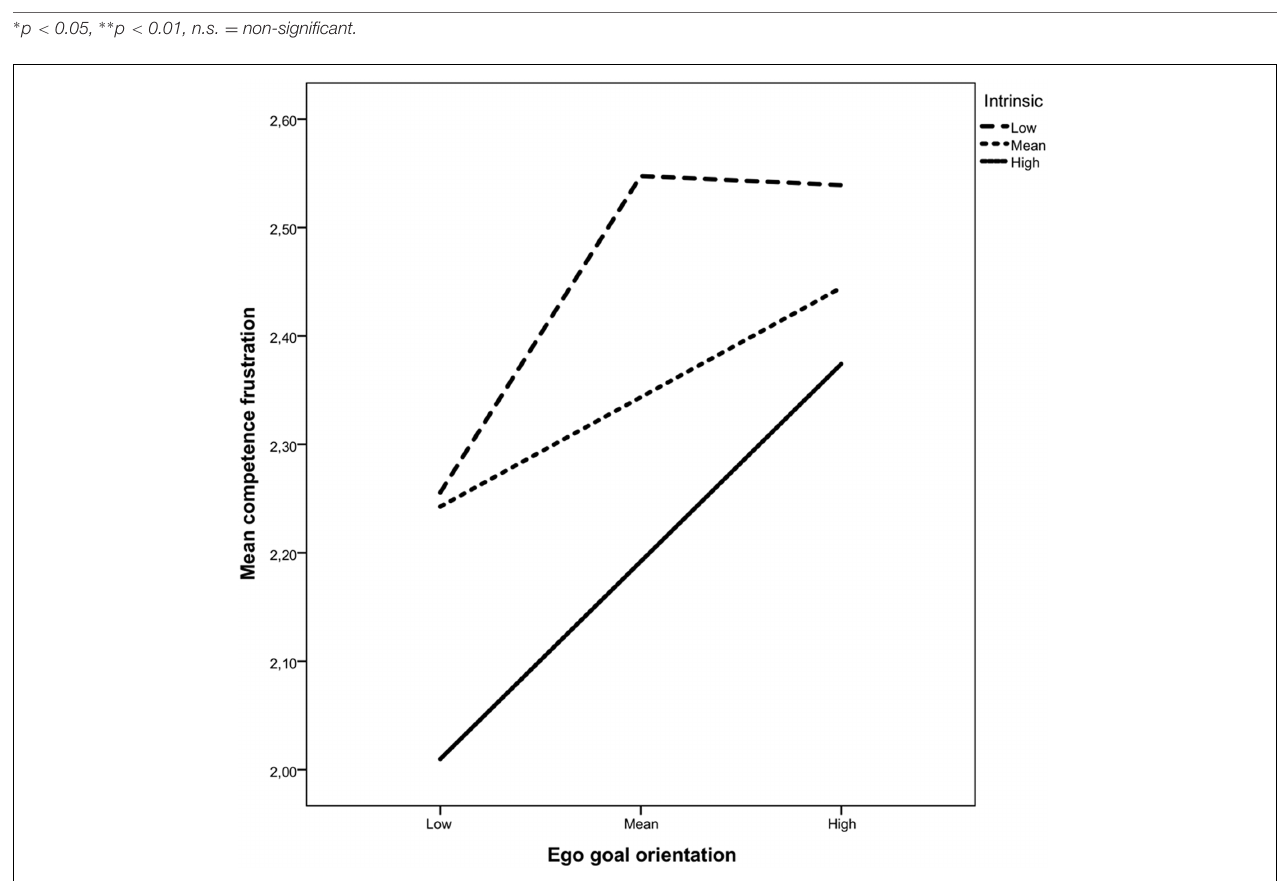
FIGURE 3 | Moderating role of intrinsic regulation on the relationship between ego goal orientation and competence